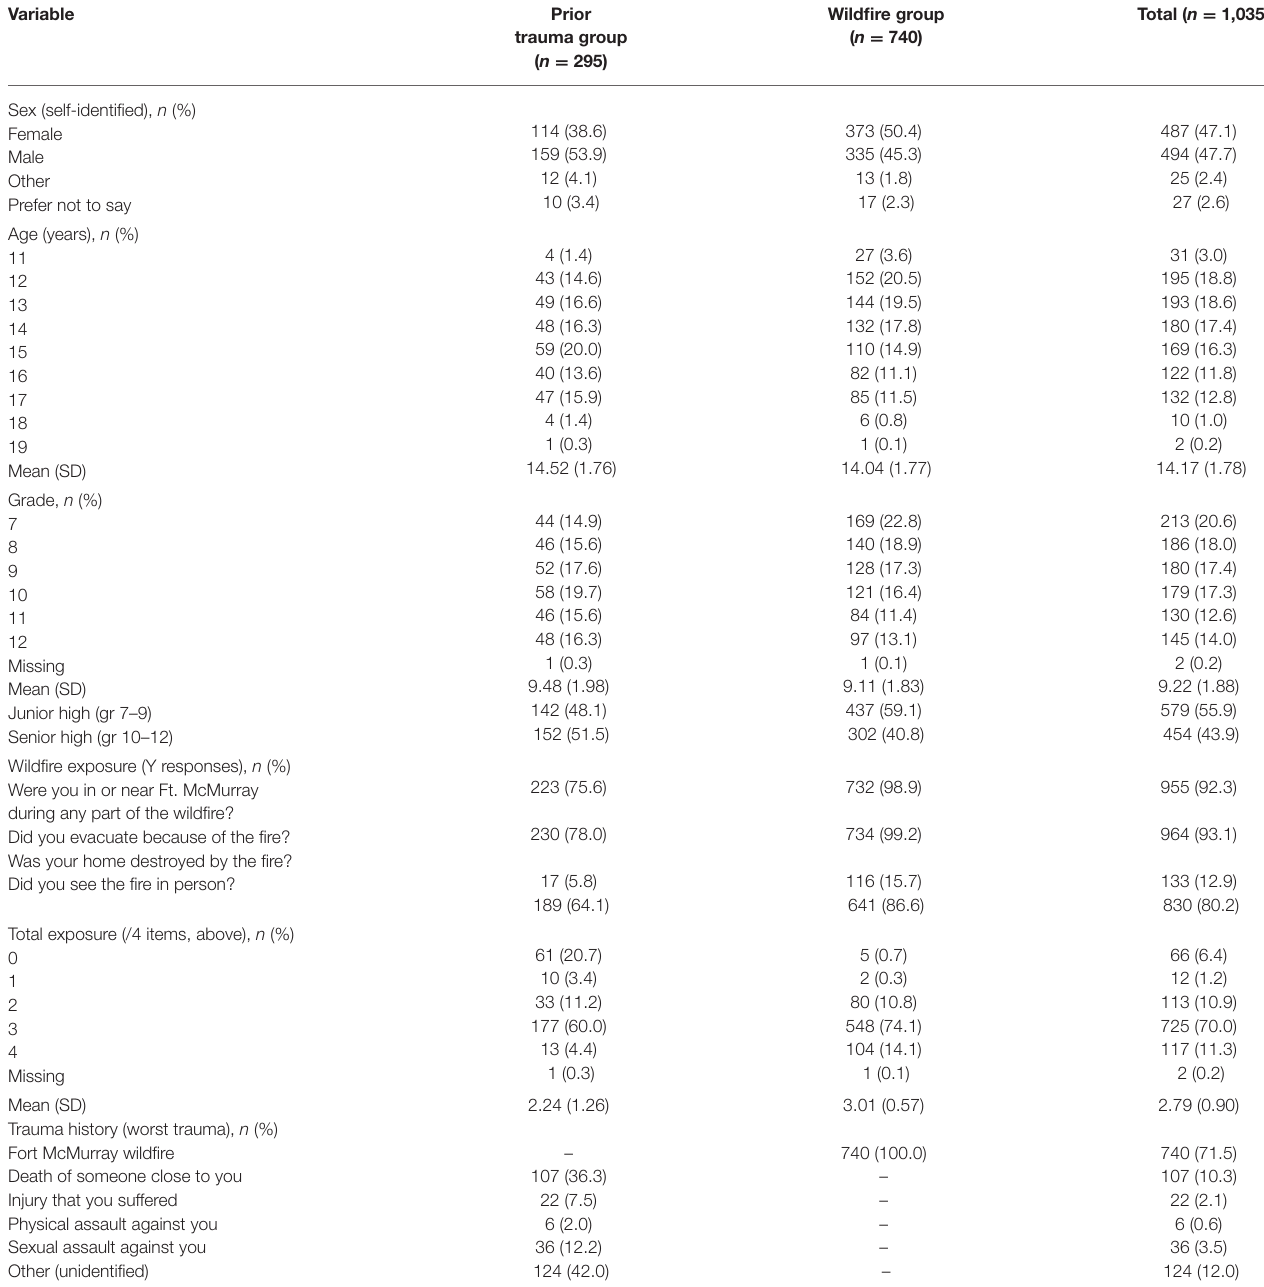
Values in parentheses are percentages, unless otherwise indicated. SD, standard